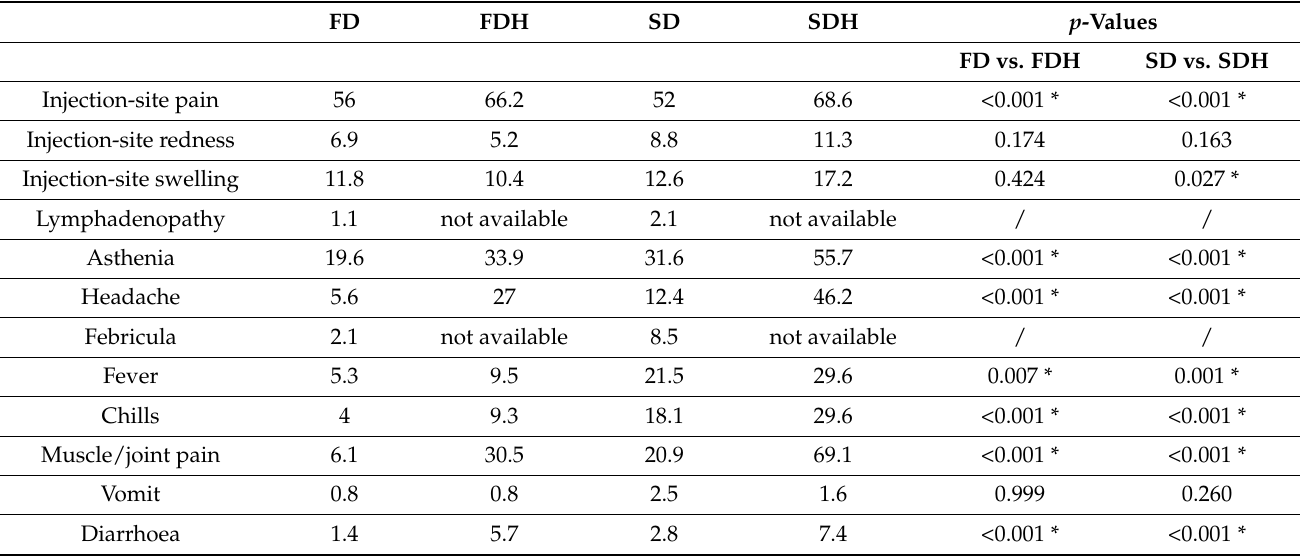
Table 2. Comparison between percentages of adverse events in our study’s population and Rosen- blum et al.‘s population on healthy individuals [13]. FD = first dose ( n = 377); SD= second dose ( n = 354); FDH = first dose on healthy individuals ( n = 5,674,420), SDH= second dose on healthy individuals ( n = 6,775,515). *: p -values reaching statistical significancy. FD FDH SD SDH p -Values FD vs. FDH SD vs. SDH